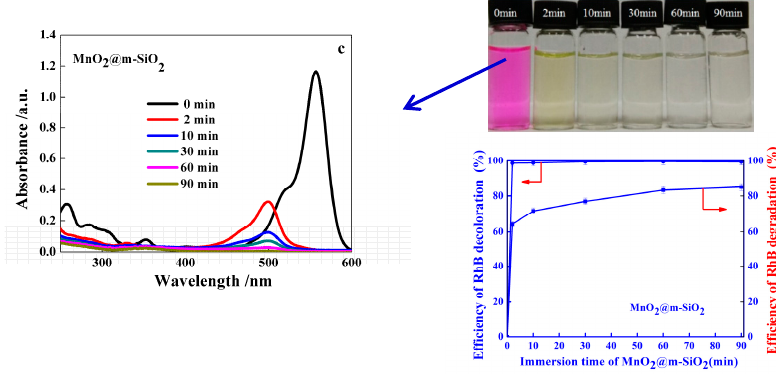
Figure 5. UV ‐ Vis spectra of the rhodamine B solution at different immersion times for MnO 2 ( a ), MnO 2 @PDA ‐ PEI ‐ SiO 2 ( b ), and MnO 2 @m ‐ SiO 2 ( c ).